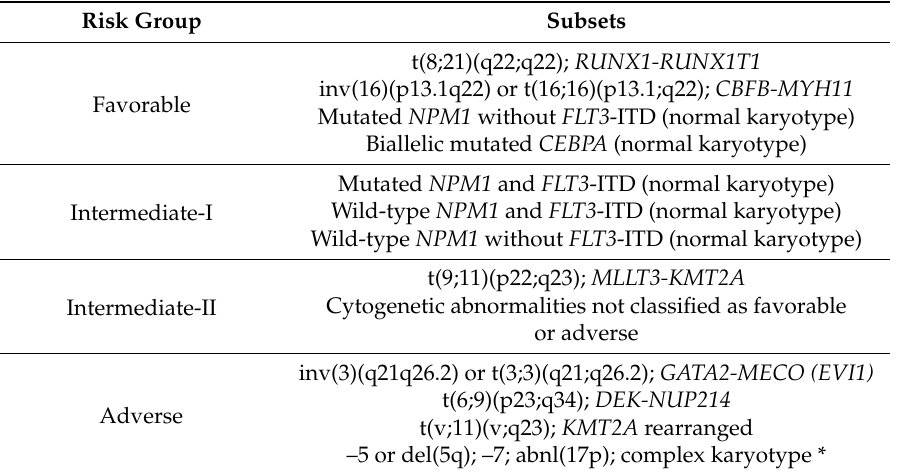
Table 1. ELN risk stratification of molecular, genetic and cytogenetic alterations. Risk Group Subsets t(8;21)(q22;q22); RUNX1-RUNX1T1 inv(16)(p13.1q22) or t(16;16)(p13.1;q22); CBFB-MYH11 Favorable Mutated NPM1 without FLT3 -ITD (normal karyotype) Biallelic mutated CEBPA (normal karyotype) Mutated NPM1 and FLT3 -ITD (normal karyotype) Wild-type NPM1 and FLT3 -ITD (normal karyotype) Intermediate-I Wild-type NPM1 without FLT3 -ITD (normal karyotype) t(9;11)(p22;q23); MLLT3-KMT2A Cytogenetic abnormalities not classified as favorable Intermediate-II or adverse inv(3)(q21q26.2) or t(3;3)(q21;q26.2); GATA2-MECO (EVI1) t(6;9)(p23;q34); DEK-NUP214 Adverse t(v;11)(v;q23); KMT2A rearranged –5 or del(5q); –7; abnl(17p); complex karyotype